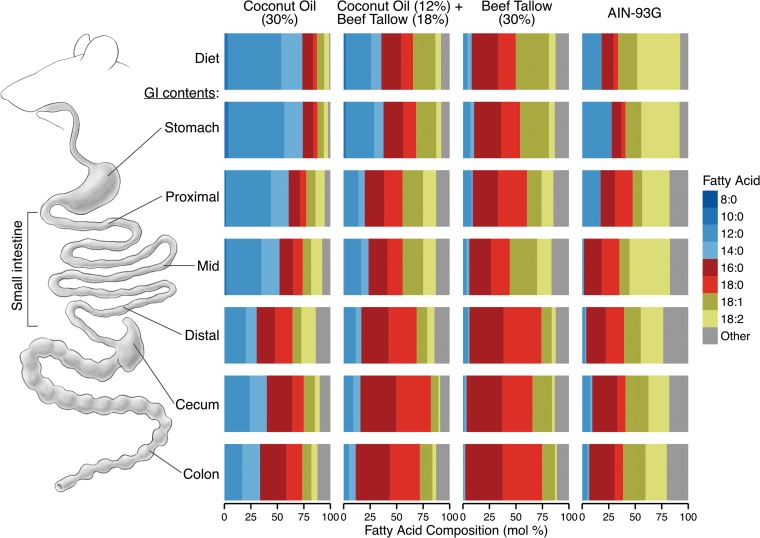
Fatty acid profile (molar percentage) of the GI contents of mice fed diets containing either coconut oil or beef tallow, a diet containing both coconut oil and beef tallow, or a standard diet (AIN-93G). To determine the effect of dietary coconut oil and beef tallow on the fatty acid composition of the GI contents, mice were fed diets containing coconut oil or beef tallow (30%), a diet containing both (12% coconut oil and 18% beef tallow), or AIN-93G. Organ contents were harvested from throughout the GI tract, and the fatty acid profiles of these samples, as well as of the original diets, were determined by gas chromatography and expressed as molar percentages. Data represent the averages for three mice per diet.